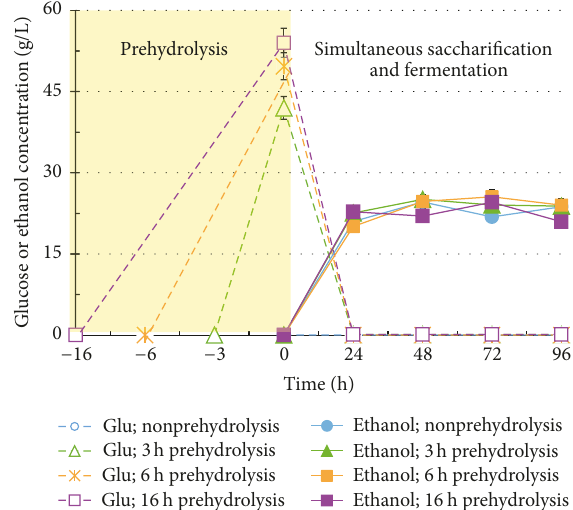
Figure 6: Concentrations of glucose and ethanol produced by SSF without/with prehydrolysis at 3, 6, and 16h (SSF conditions: 10% solid loadings, cellulase and xylanase dosages of 15FPU and 100 XU/g solid, and 37 ∘ C). Glu is short for